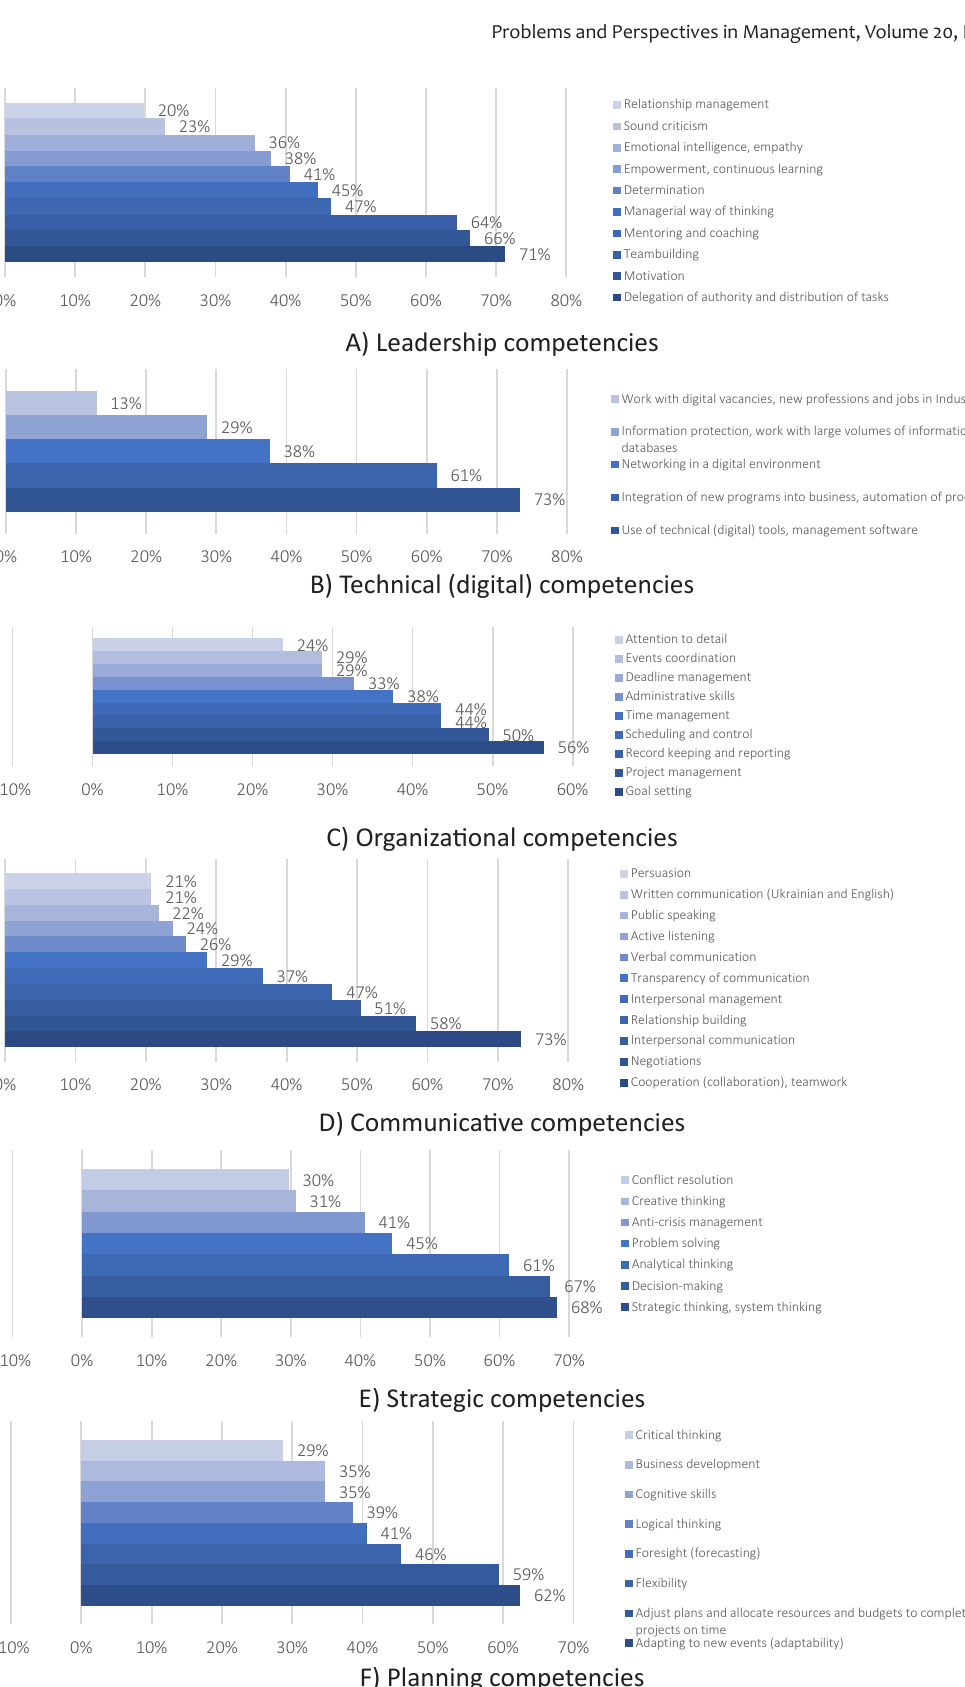
Figure 5. The results of an expert survey on demand for managerial competencies in the labor market of Ukraine in terms of